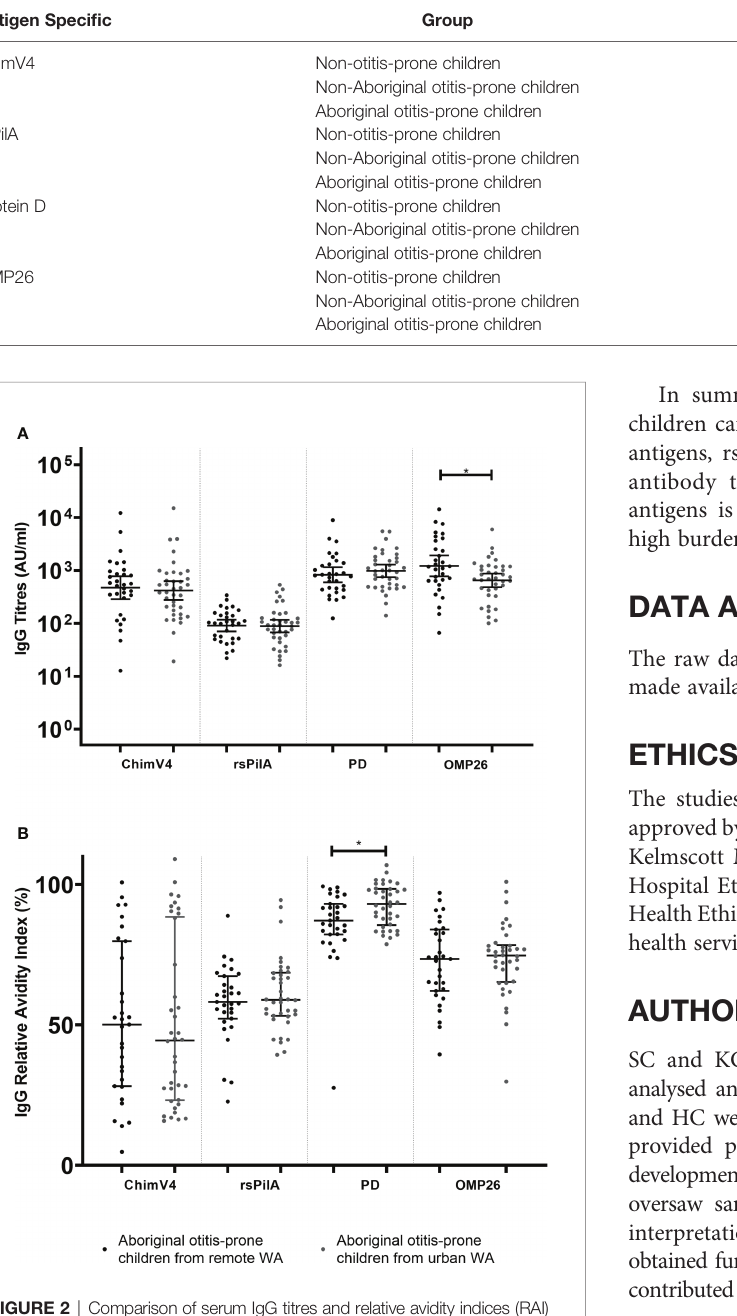
FIGURE 2 | Comparison of serum IgG titres and relative avidity indices (RAI) between Aboriginal otitis-prone children living in remote and urban Western Australia. (A) Comparison of serum IgG titres between remote and urban Aboriginal otitis-prone children. Levels of serum IgG against NTHi proteins are presented for each individual child, with the horizontal bars depicting the GMC ± 95%CI (not age adjusted). Statistical analyses were conducted on the log transformed GMC data, adjusted for age. (B) Comparison of serum IgG RAI between remote and urban Aboriginal otitis-prone children. RAI serum IgG against NTHi proteins are presented for each individual child, with the horizontal bars depicting the median ±Interquartile Range. ChimV4, chimeric protein V4 (rsPilA+ protein 5), rsPilA,recombinant soluble PilA; PD, Protein D; OMP26, outer membrane protein 26. *P ≤